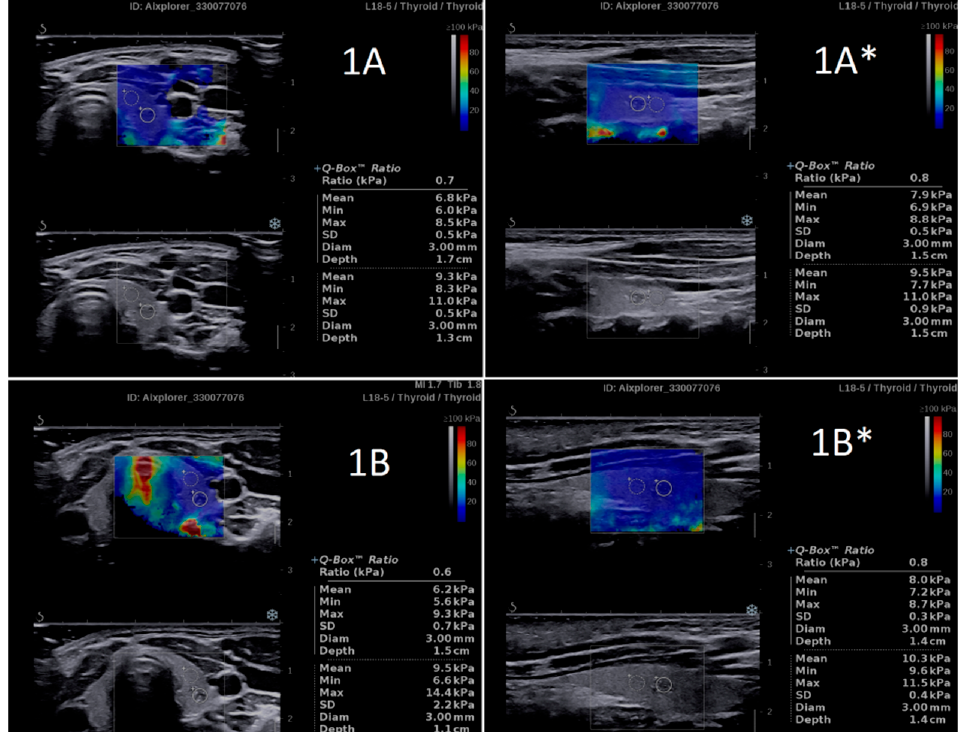
Figure 1. An example of the SWS and SWR results obtained by two independent researchers (( A ) R1 and ( B ) R2—Patient 1. A high similarity is clearly visible for both the SWS and SWR values. * Longitudinal plane imaging. SWR, shear wave ratio; SWS, shear wave stiffness.